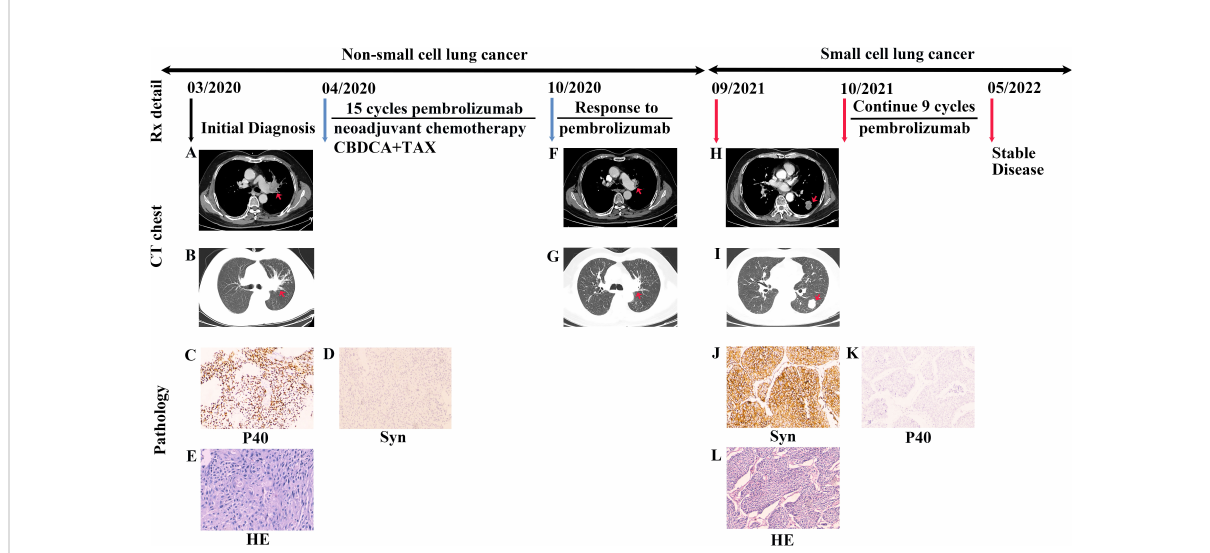
FIGURE 2 Case presentation of transformation of lung squamous cell carcinomas to small cell lung carcinoma with pembrolizumab. (A, B) Chest CT scan showing a space-occupying lesion of the left hilar with mediastinum window and lung window. (C, D) Biopsied specimens subjected to IHC staining showed that P40 was strongly positive, and Syn was negative (P40 and Syn staining, ×100 magni fi cation). (E) Based on resected specimens, the pathological diagnosis was lung squamous cell carcinoma (H&E staining, ×200 magni fi cation). (F, G) The patient was treated with a regimen of ICIs combined with chemotherapy and exhibited a partial response. The lesion was signi fi cantly reduced in the mediastinum window and lung window than before treatment. (H, I) After completing 15 cycles of immunotherapy, CT scans revealed tumor progression